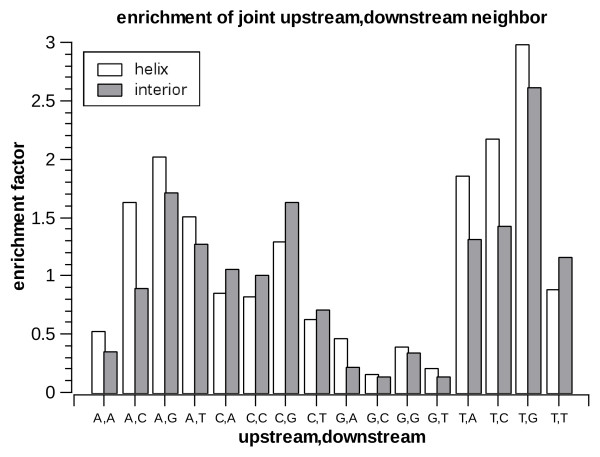
Enrichment factors for joint upstream, downstream nucleotides in helices and interior loops.